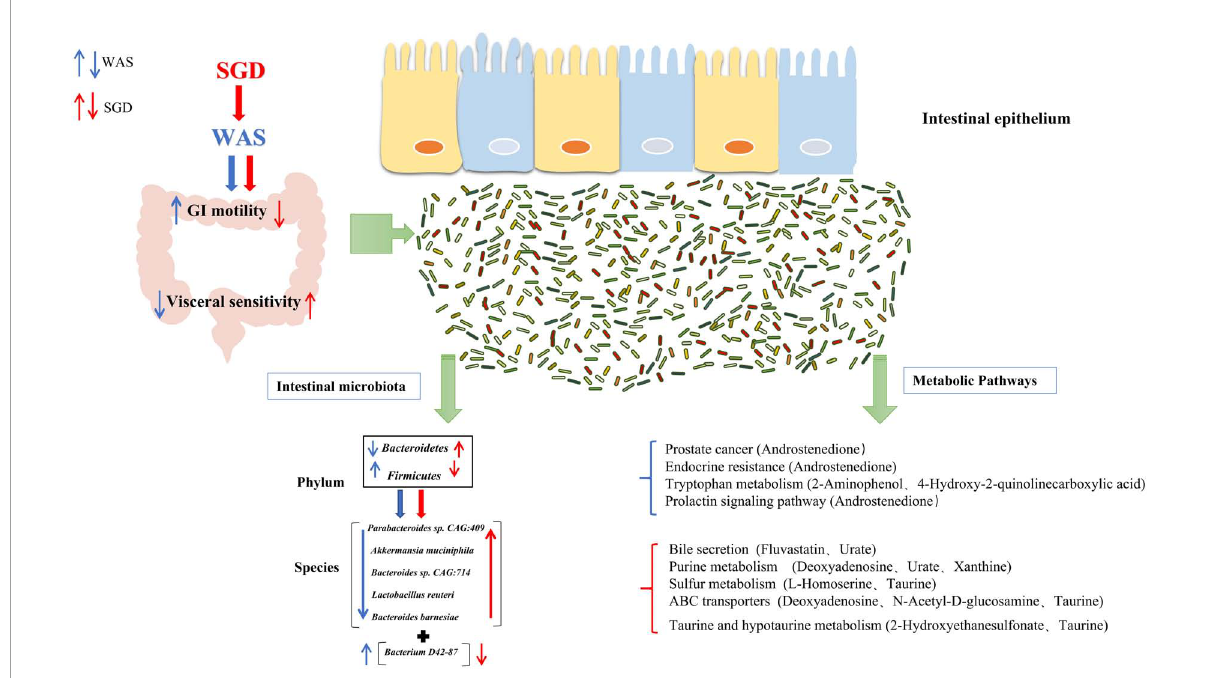
FIGURE10 Effect of SGD on intestinal microbiota in IBS-D